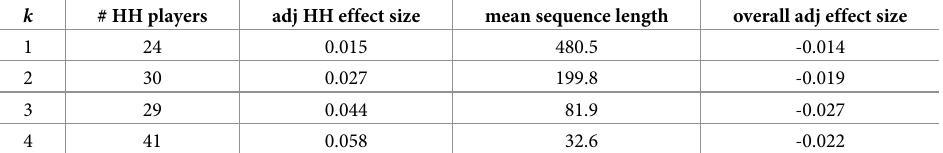
Table 2. While overall the league exhibits shooting regression (last column), there are players that have the hot hand (HH) to different degrees (second column). Out of the 153 qualified players for our statistical tests at least 24 players provided statistical evidence for streakiness at the 5% significance level for all values of k examined. The proba- bility of obtaining at least 24 false positives at the 5% level is less than